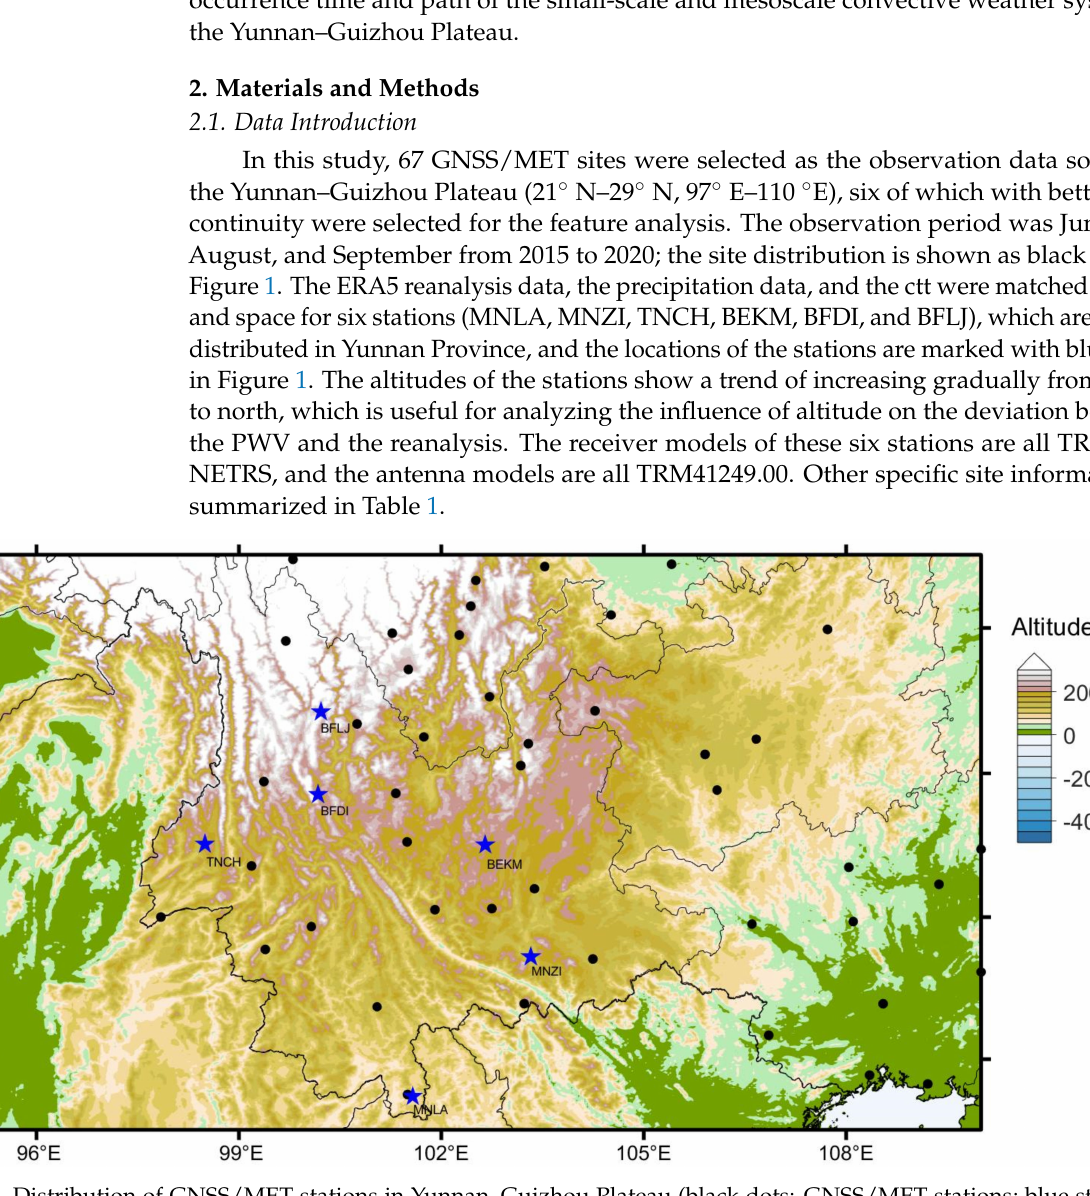
Figure 1. Distribution of GNSS/MET stations in Yunnan–Guizhou Plateau (black dots: GNSS/MET stations; blue star: GNSS/MET stations matching the ERA5, the precipitation, and the